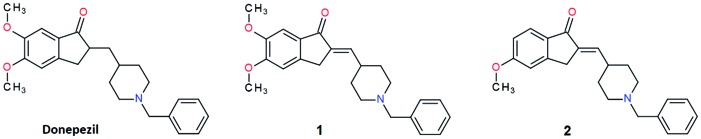
Structural formulas of donepezil and donepezil-analogs 1 and 2.